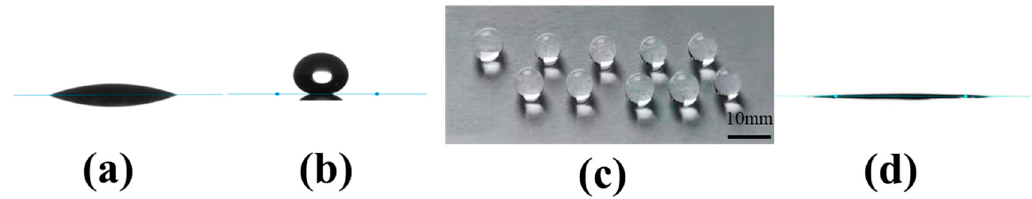
Figure 5. Water and hexadecane CAs of the pristine silica and methylated superhydrophobic silica coatings. ( a ) Water CA on the pristine silica coating, ( b ) water CA on the methylated silica coating, ( c ) digital photo of water droplets on the surface of a methylated-silica-treated glass slide, and ( d ) hexadecane CA on the methylated silica coating.